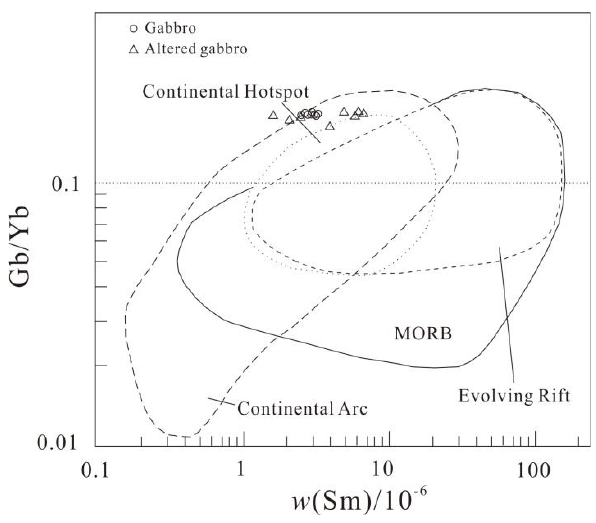
Figure 10. Th/Yb versus Ta/Yb discrimination diagram for Ping’an gabbros.